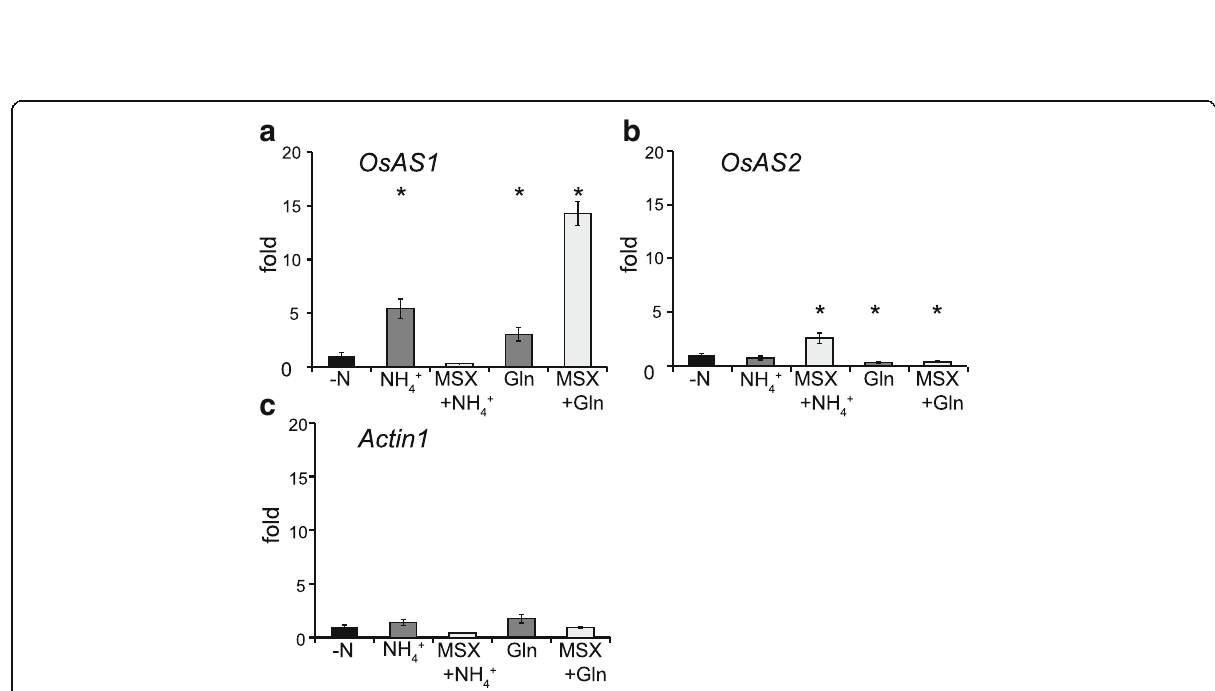
Fig. 5 qPCR analysis of OsASs in the basal portions of wild-type shoots using MSX. Wild-type rice seedlings were grown hydroponically in the presence of 1 mM NH 4 Cl until the fourth-leaf stage and then transferred into water for 3 d. After pre-treatment with 1 mM MSX for 2 h, the seedlings were treated for 8 h with 1 mM NH 4+ (MSX + NH 4+ ) or 5 mM glutamine (MSX + Gln). The seedlings without MSX pre-treatment were also treated for 8 h with 1 mM NH 4+ (+NH 4+ ), 5 mM glutamine (Gln) or without nitrogen nutrients (-N). qPCR analyses of OsAS1 ( a ), OsAS2 ( b ), and actin1 transcripts ( c ) were performed in the shoot basal parts. Fold changes of transcript levels in each treatment relative to those in – N were calculated, and mean values with SE of four independent samples are shown. Asterisks denote statistically significant differences between the samples treated without nitrogen nutrients (-N) and each treated sample (*, P < 0.05 by Student ’ s t